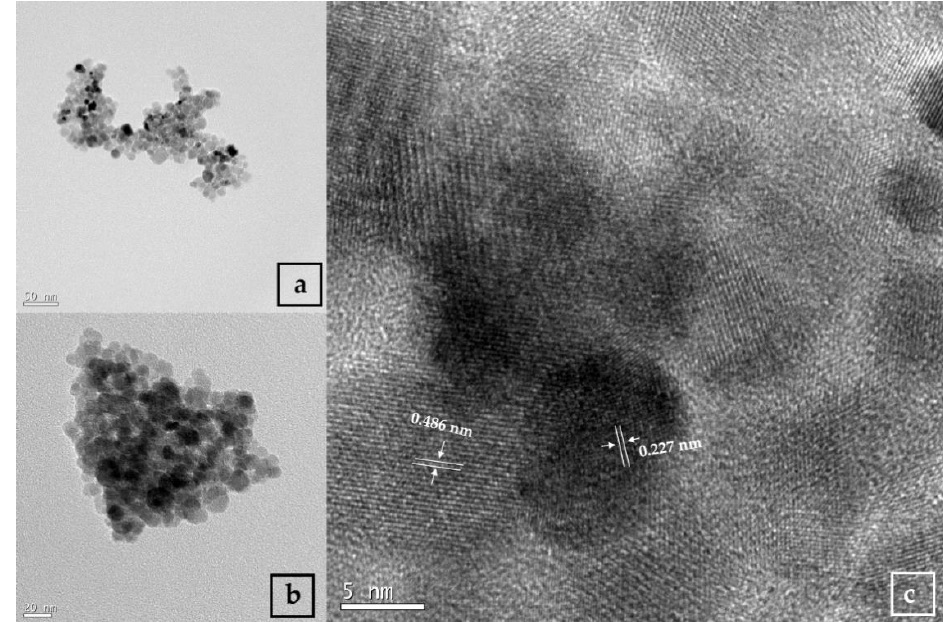
Figure 1. ( a , b ) Pt–Fe 3 O 4 nanoparticles TEM image; ( c ) Pt–Fe 3 O 4 nanoparticles HR-TEM image (white line indicates the gap between two lattice planes of nanoparticle).